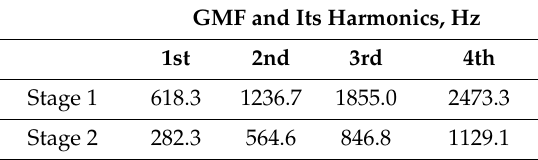
Table 2. Gear mesh frequency (GMF) at the rated